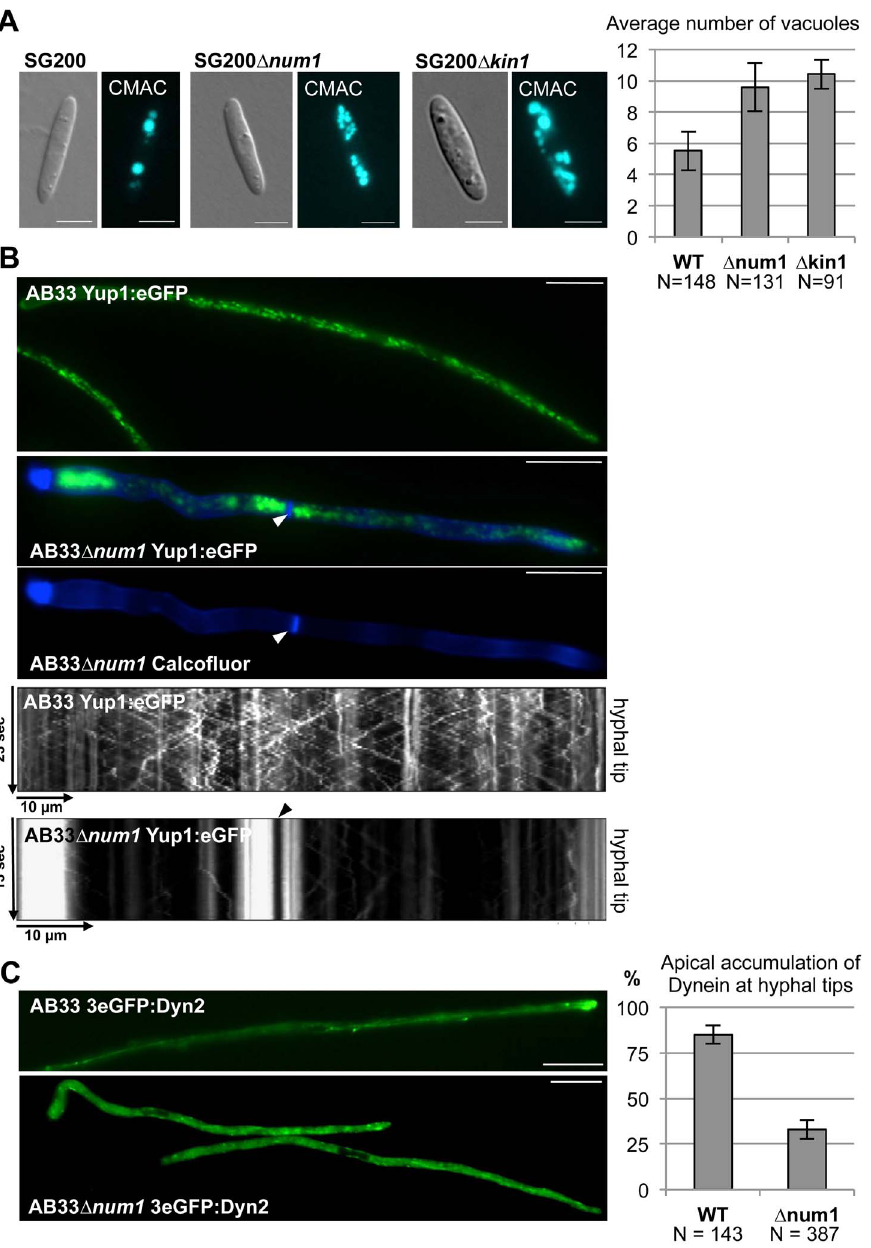
Figure 6. Num1 and Kin1 are functionally connected. ( A ) The num1 deletion leads to aberrant vacuole morphology. Vacuoles were visualized by CellTracker Blue (7-amino-4-chloromethyl-coumarin, CMAC) staining. Both num1 and kin1 deletion strains contain more, but smaller vacuoles in comparison to wild-type sporidia. Scale bars: 5 m m. Right panel: Quantification of the average number of vacuoles of strains indicated. N represents the number of individual cells analyzed. Mean values of three independent experiments are shown. ( B ) The num1 deletion leads to an aberrant distribution of early endosomes. For visualization of early endosomes, a Yup1:eGFP fusion protein [9] was expressed under control of the constitutively active P otef -promoter in strains AB33 and AB33 D num1 , which harbor b -genes under control of the nitrate-inducible P nar1 -promoter. Endosomes were analyzed 14 hours after bE1/bW2 -induction. Septa (arrowhead) were visualized by Calcofluor White staining. Yup1-labelled early endosomes accumulate at basal and apical parts of the hyphae as well as around delocalized septa in AB33 D num1 in contrast to wild-type hyphae. Scale bars: 10 m m. Movies detecting Yup1:eGFP-fluorescence of the depicted hyphae are shown in Videos S1 and S2. Shown below are the corresponding kymographs (time and distance as indicated) reflecting the motility of early endosomes. In AB33 hyphae, early endosomes travel continuously towards the hyphal tip (anterograde) and reverse direction to travel back towards the septum (retrograde). Pausing organelles are reflected by a vertical line. In contrast, endosomal motility is drastically reduced in AB33 D num1 hyphae containing additional septa, where the majority of the Yup1:eGFP-signal is non-motile. An arrowhead indicates the septum. ( C ) The localization of Dynein is dependent on Num1. In AB33 filaments 3eGFP:Dyn2 fusion proteins form comet-like motile structures that accumulate at the hyphal tip and from there move into retrograde direction [9]. In filaments of AB33 D num1 strains the apical accumulation is significantly reduced (p=0.002); instead a stronger signal is observed in the cytoplasm. Dynein localization was monitored 14 hours after induction of the bE1/bW2 heterodimer. Scale bars: 10 m m. Right panel: Quantification of the apical accumulation of 3eGFP:Dyn2 fusion proteins. N represents the number of hyphae analyzed. Mean values of three independent experiments are shown. doi:10.1371/journal.pgen.1004046.g006 PLOS Genetics |